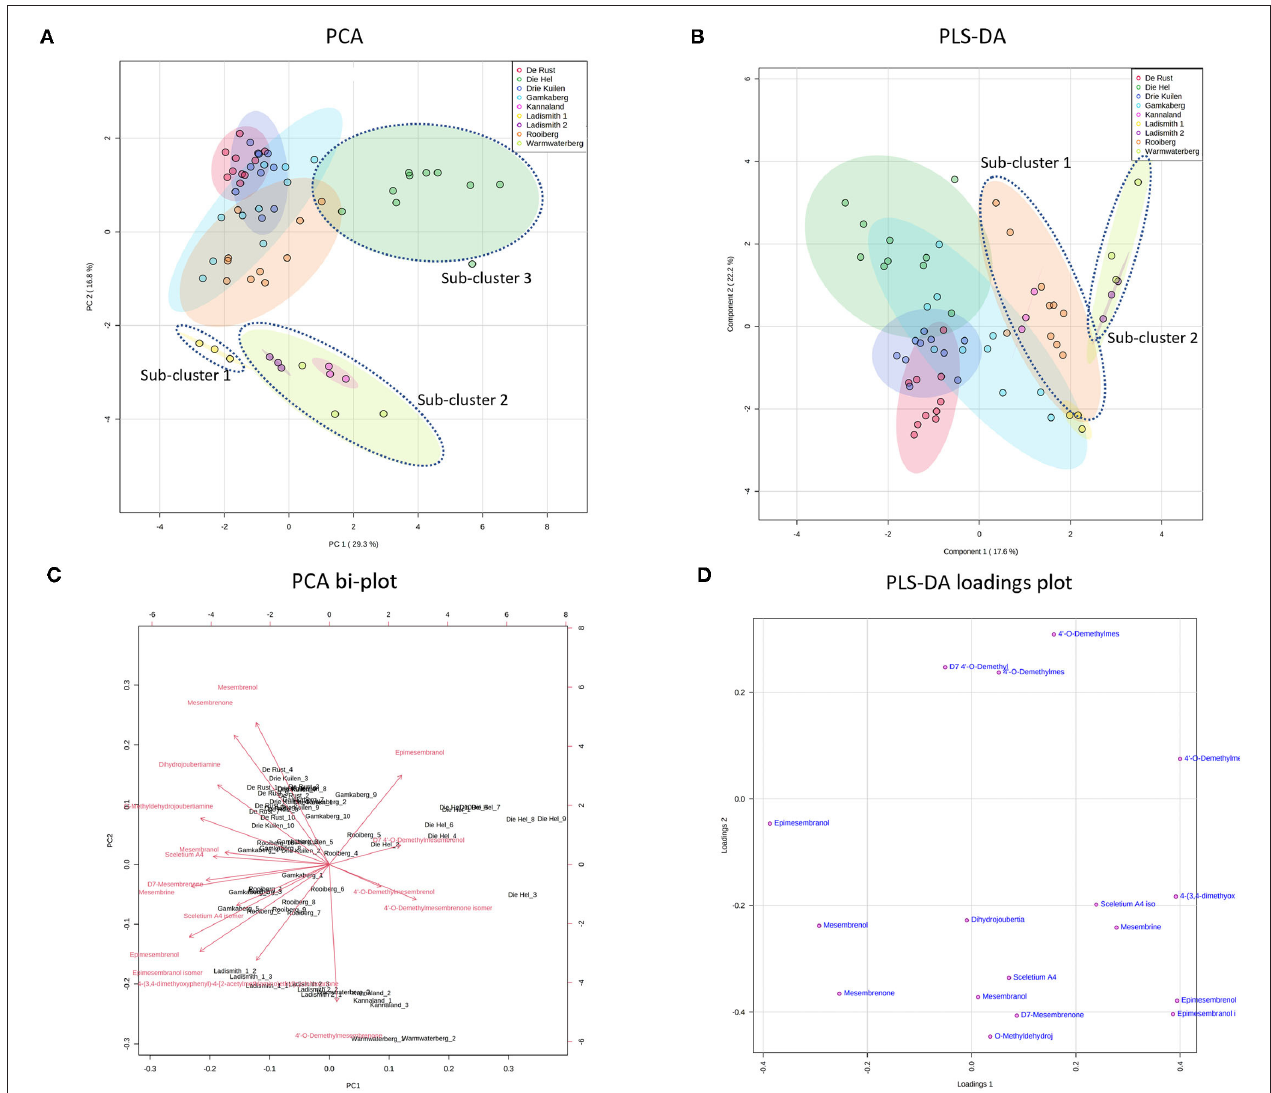
FIGURE 3 | (A) PCA on all populations of S. tortuosum used in the study. (B) PLS-DA on all populations of S. tortuosum ; (C) PCA bi-plot of phytochemicals contributing to separation between populations of S. tortuosum ; (D) PLS-DA loadings plot of phytochemicals contributing to the